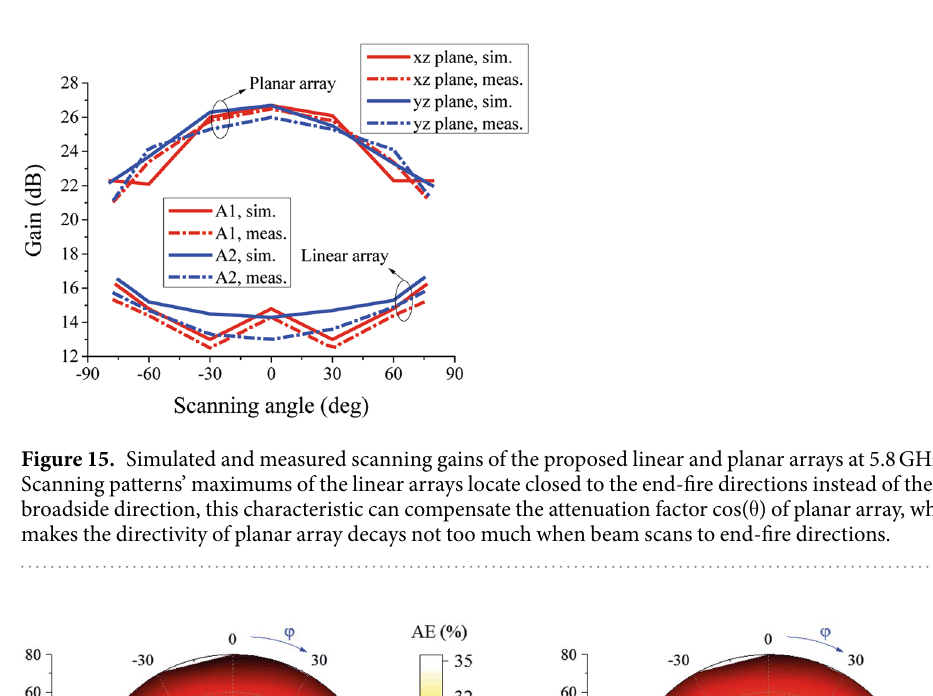
Figure 14. Simulated and measured scanning patterns of the planar array in ( a ) xz plane and ( b ) yz plane at 5.8 GHz. Main beams can scan from less than − 77° to more than + 77° with a gain fluctuation less than 5 dB. The two scanning planes have similar performances.